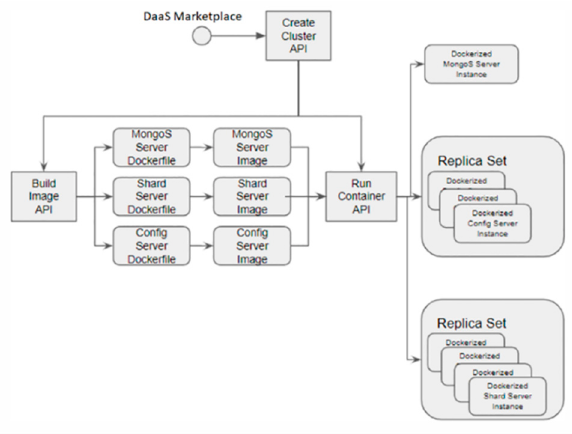
Figure 9. Data repository scaling deployment API architecture.